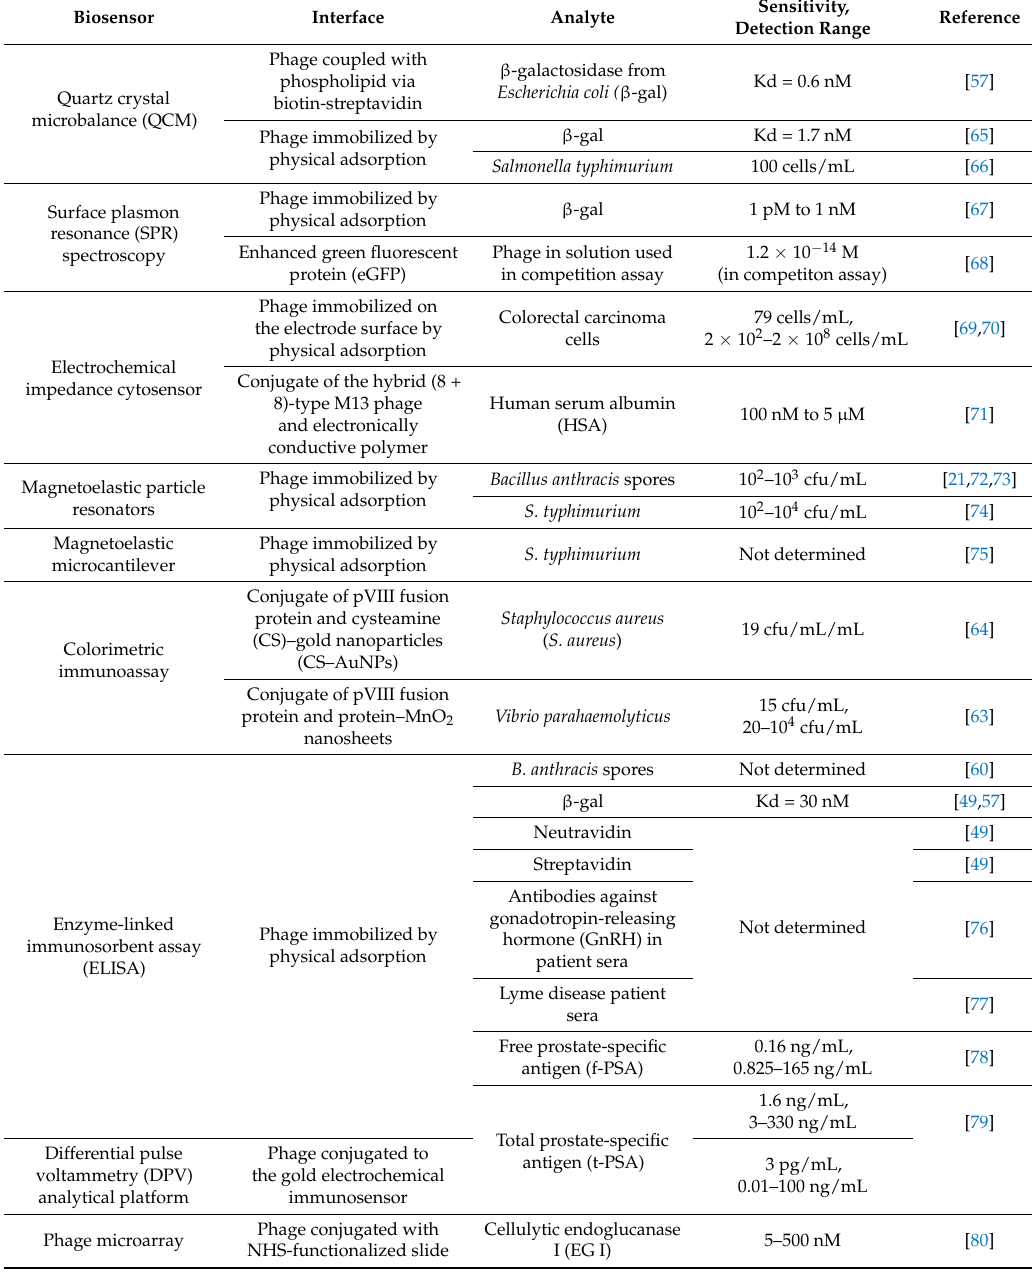
Table 2. Performance of landscape-phage-based